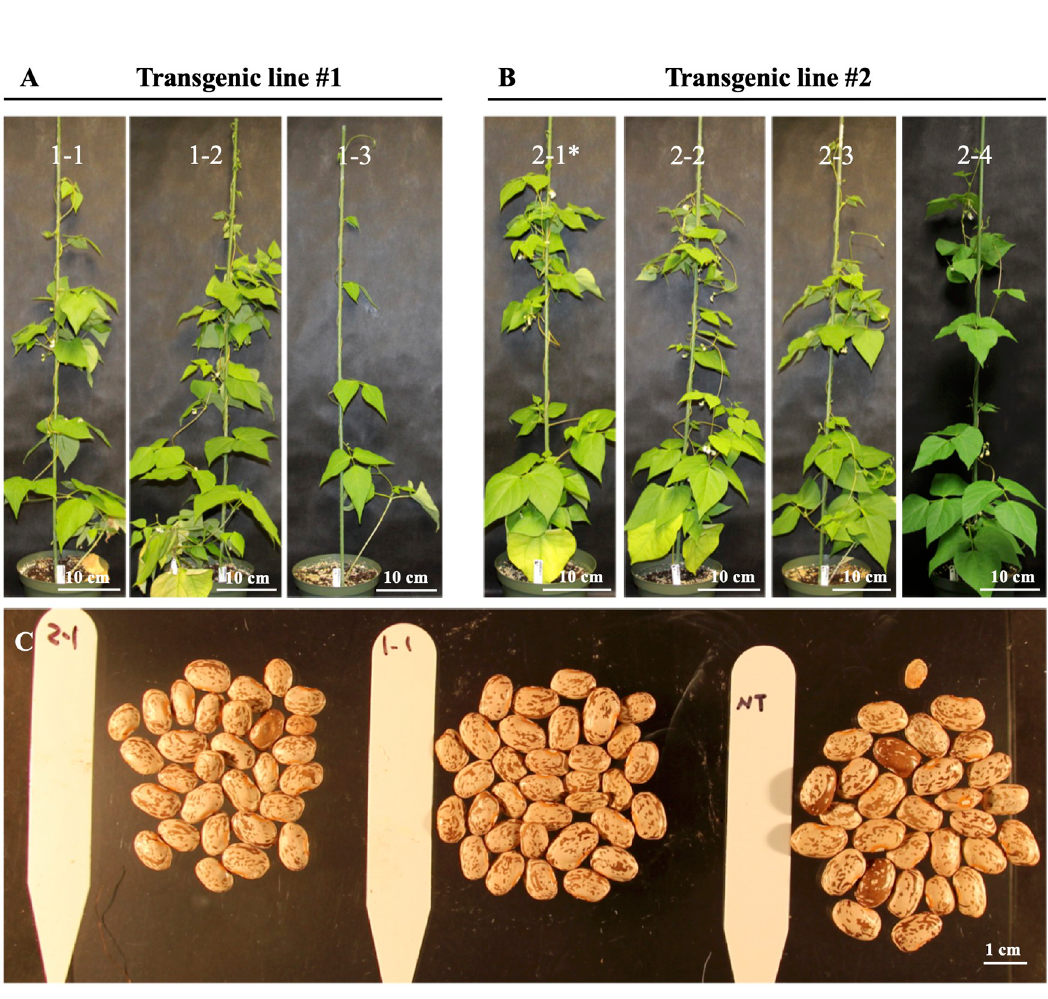
Fig 5. T 1 plants and T 2 seeds. (A, B) T 1 plants of two transgenic lines of ‘Olathe’ pinto bean. Except 2–1 � , all the other plants are RT-PCR-positive for the bar gene. (C) Seeds from transgenic 1–1 and nontransgenic (NT) 2–1 and NT plants.